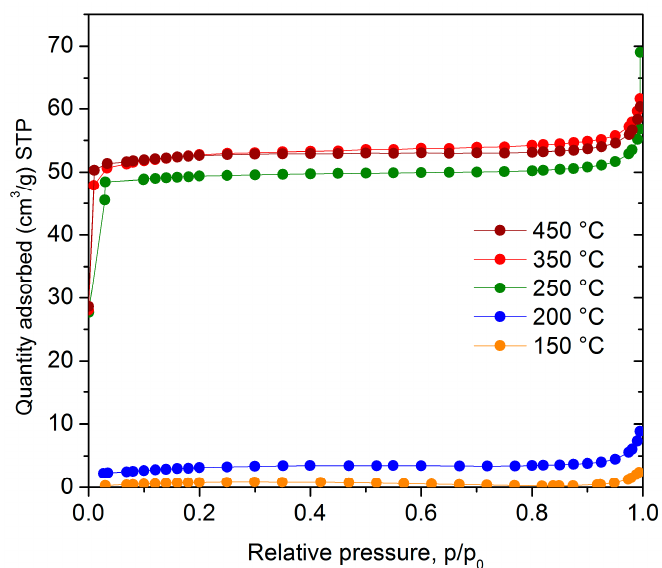
Figure 4. N 2 Adsorption isotherms at − 196 °C measured on Ce 5 (BDC) 7.5 (DMF) 4 . at different activation temperatures (150 °C, 200 °C, 250 °C, 350 °C, 450 °C).